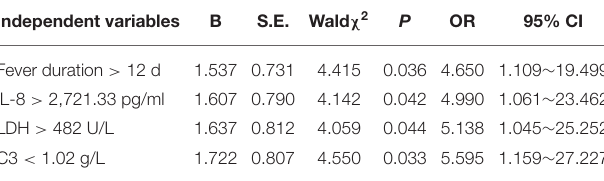
TABLE 2 | Risk factors for PB in children with